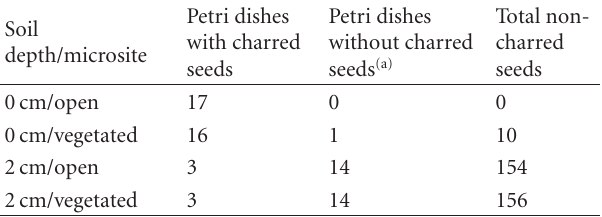
(a) Morepetridisheswithnon-charredseedswererecoveredfrom2cmdepth ( χ 2 = 43 . 95, P < .